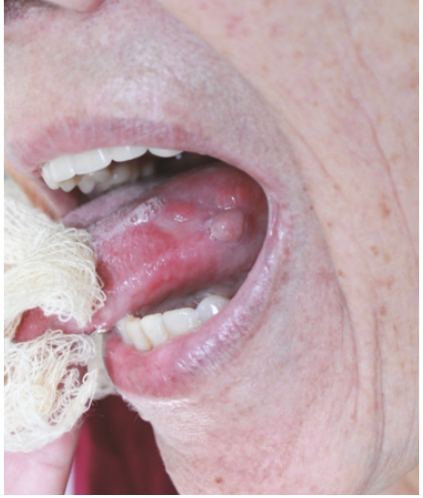
Figure 10: Postoperative week 8.